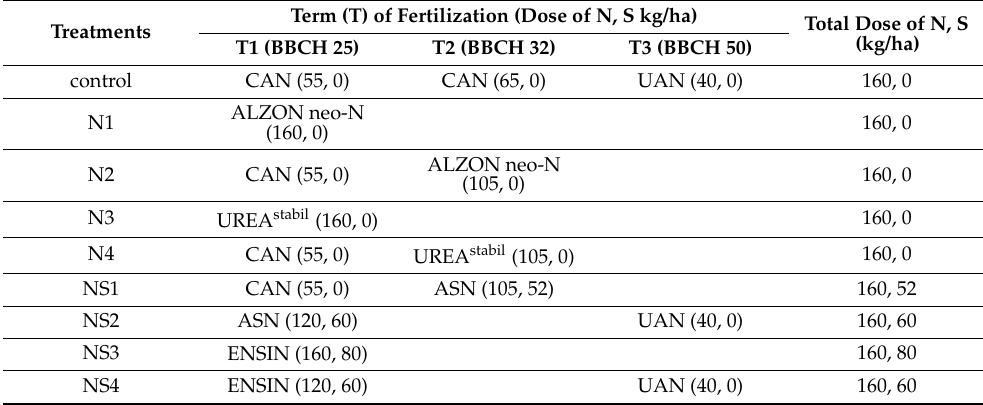
Table 2. Treatments and doses of fertilizers.